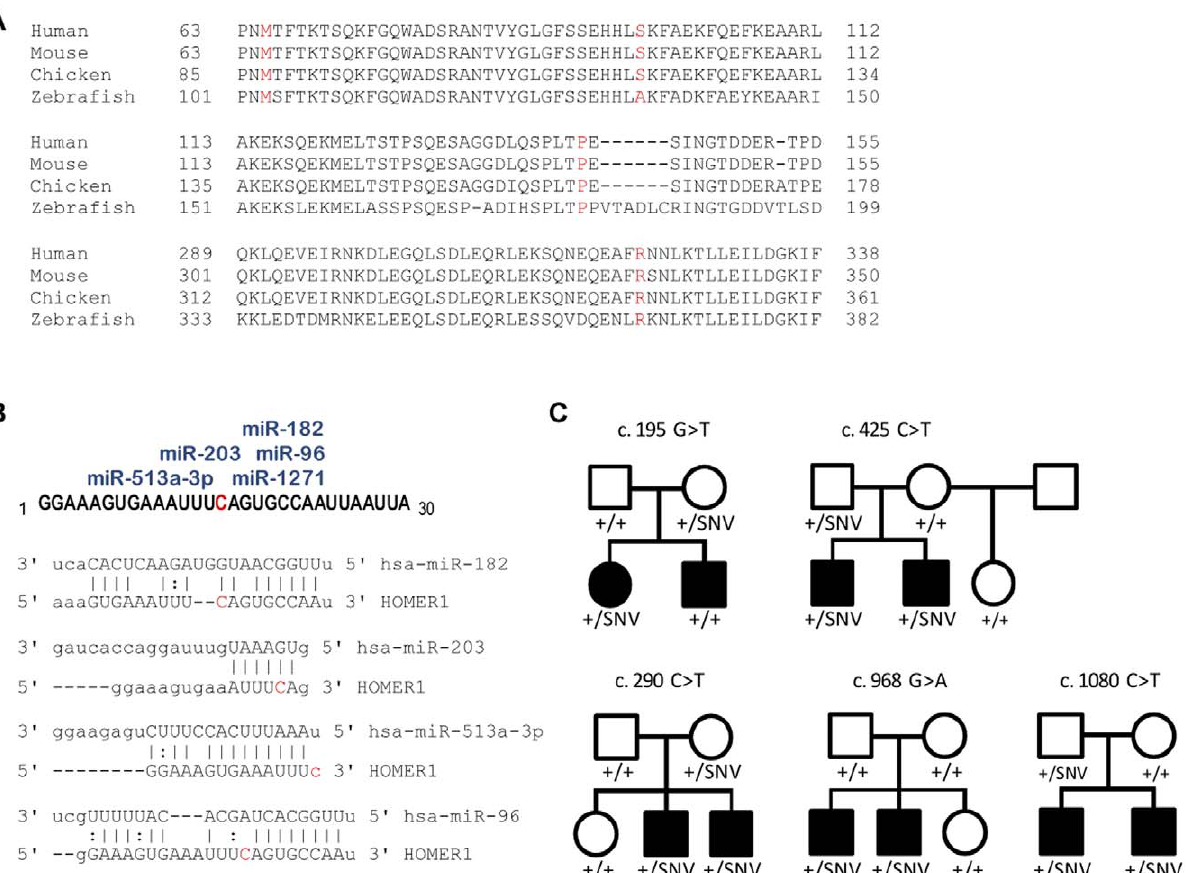
Figure 3. Autism-specific HOMER1 variants affect conserved residues or microRNA binding sites and co-segregate with autism. (A) Multiple sequence alignments are shown for three segments of the Homer1 protein that contain missense substitutions caused by autism-specific SNVs identified in this study. The amino acid residues altered by these substitutions (highlighted in red) are highly conserved across mammalian and/ or vertebrate evolution. (B) The autism-specific HOMER1 c.1080C . T variant is predicted to alter multiple microRNA-binding sites in the HOMER1 3 9 UTR. The sequence of the HOMER1 3 9 UTR is shown at top (the c.1080 position 15 nucleotides distal to the translation stop codon highlighted in red), together with a cluster of microRNA binding sites predicted by the miRanda and Microcosm applications (miRanda target prediction based on $ 6- mer seed complementarity and mirSVR score # 0.1) [32,33]. Predicted pairing between specific microRNAs and the HOMER1 3 9 UTR that would be altered by the c. 1080 C . T variant is shown at bottom. (C) Co-segregation with autism was analyzed for the rare, potentially deleterious HOMER1 missense variants uniquely identified in AGRE probands by genotyping available parents and siblings. Filled symbols indicate a diagnosis of autism or ASD; unfilled symbols indicate reportedly unaffected individuals. Genotypes are shown for each individual, with ‘‘ + ’’ designating the wild-type allele and ‘‘SNV’’ designating the indicated variant allele.